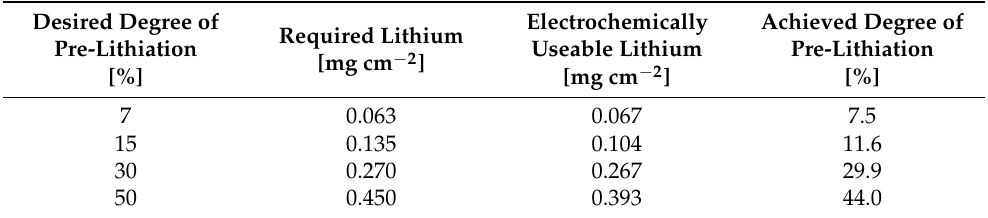
Table 3. Different achieved degrees of pre-lithiation by using different lithium loadings on the temporary substrates. Pre-lithiation was performed at 40 MPa, 175 ◦ C for 15 min. Achieved Degree of Electrochemically Desired Degree of Required Lithium Pre-Lithiation Useable Lithium Pre-Lithiation [mg cm − 2 ] [mg cm − 2 ] [%] 0.063